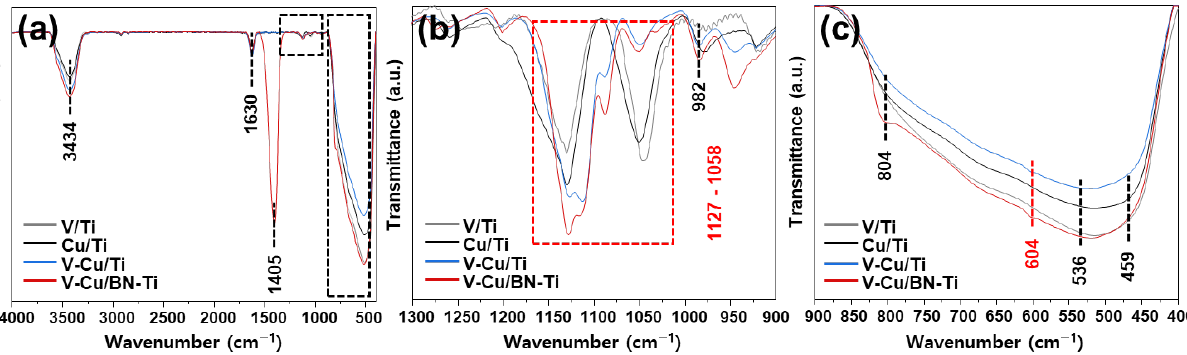
Figure 3. Acidity properties analysis of the synthesized catalysts. ( a ) Full FT-IR spectra and magnified, ( b ) 1300–900 cm − 1 , and ( c ) 900–400 cm − 1 regions. V/Ti, gray line; Cu/Ti, black line; V-Cu/Ti, blue line; V-Cu/BN-Ti, red line.